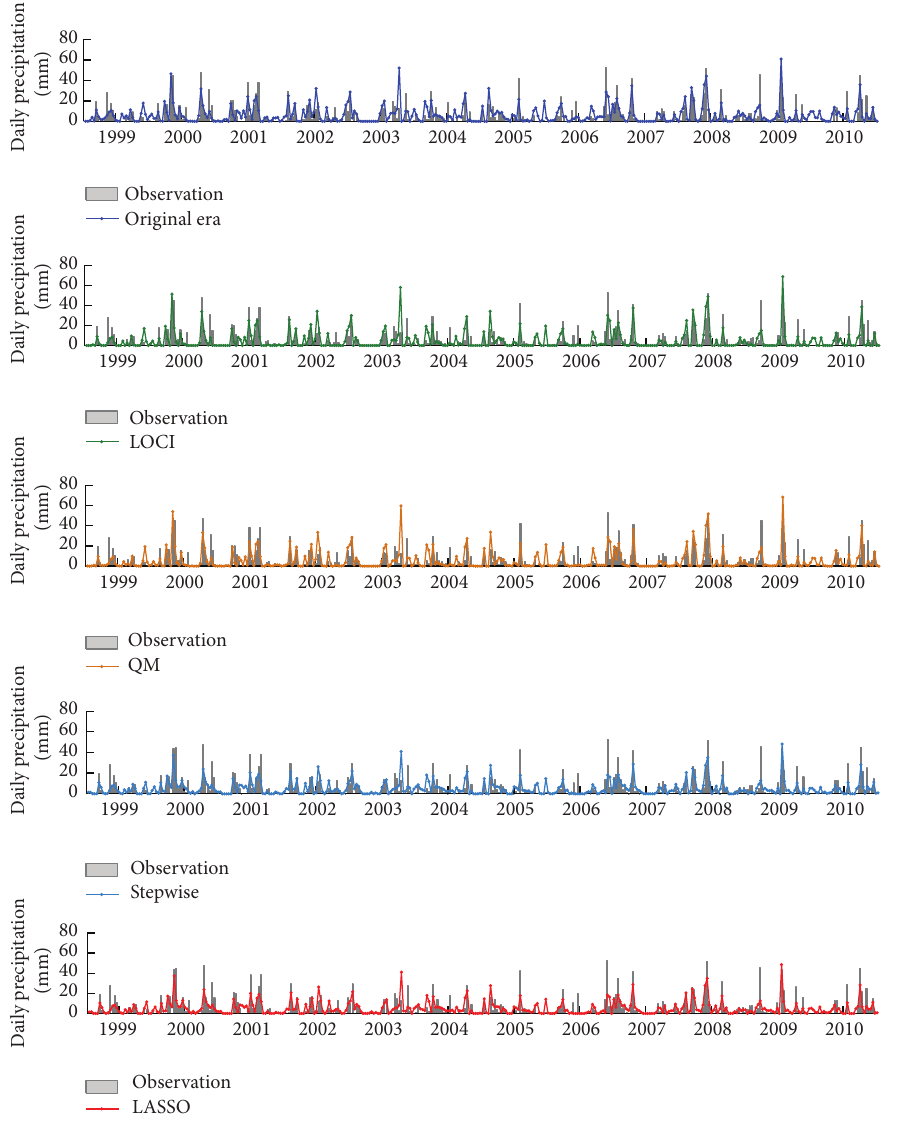
Figure 6: Comparison of observations with downscaled daily precipitation for the four downscaling methods, as well as the original ERA- Interim data in July at station WFJ during the validation period